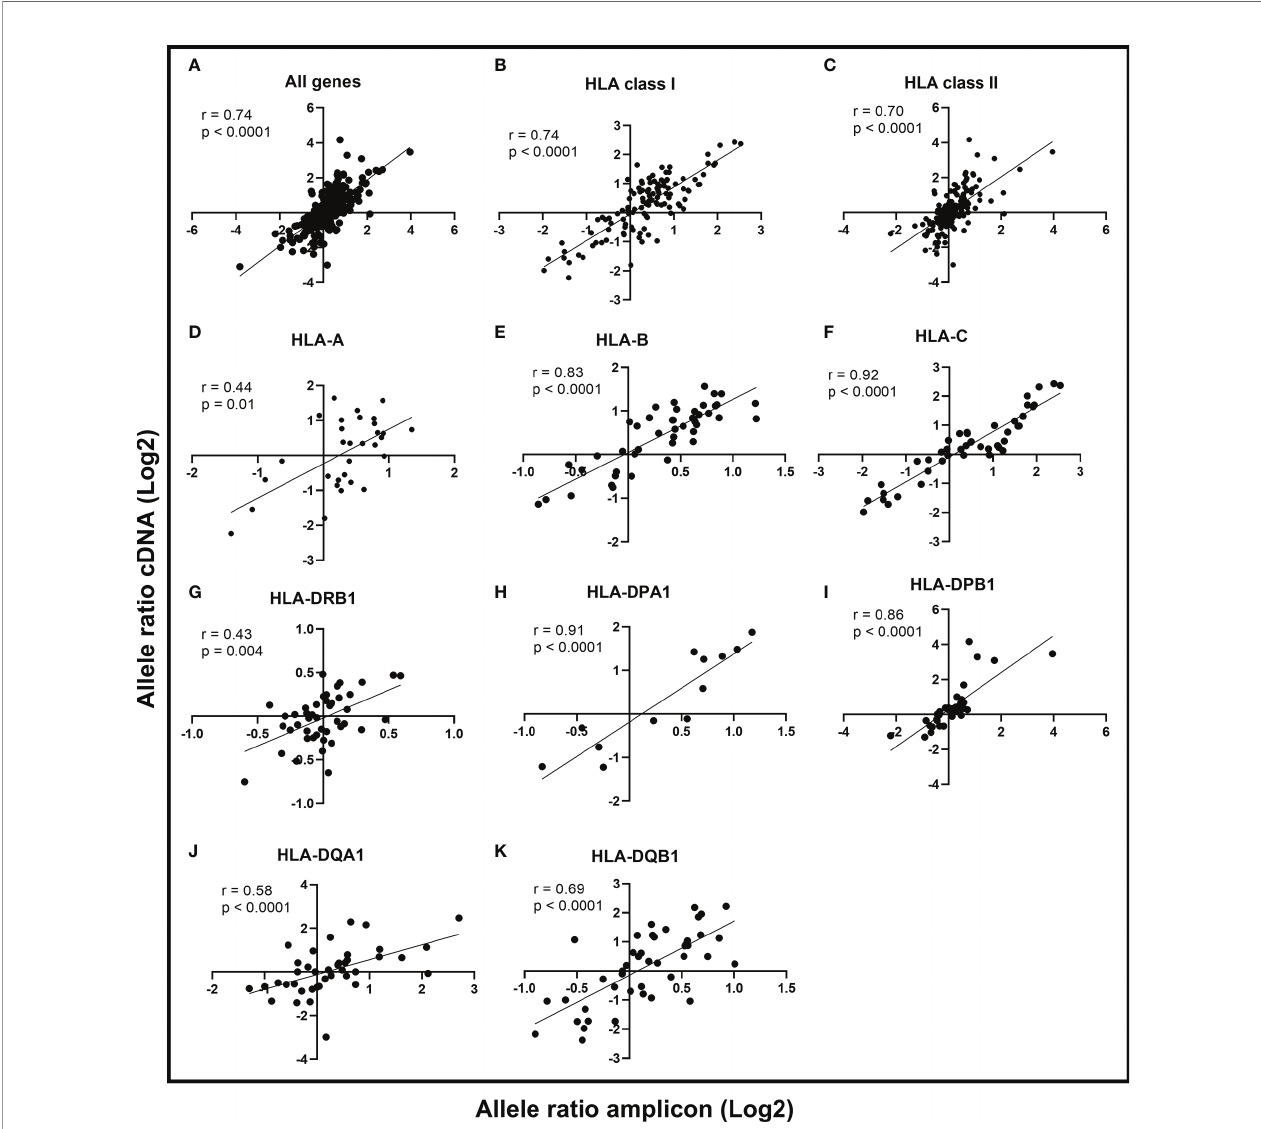
FIGURE 2 | Comparison of allele ratios between Illumina cDNA and Illumina amplicon datasets. The allele expression ratio was calculated for each heterozygous allele pair in the two datasets and a non-parametric Spearman ’ s rank correlation was used to compare the allele-level expression between cDNA and amplicon data. The line indicates the linear regression. The Spearman correlation coef fi cient is given for all genes (A) , HLA class I (B) , HLA class II (C) , and for genes HLA-A (D) , HLA-B (E) , HLA-C (F) , HLA-DRB1 (G) , HLA-DPA1 (H) , HLA-DPB1 (I) , HLA-DQA1 (J) , and HLA-DQB1 (K)